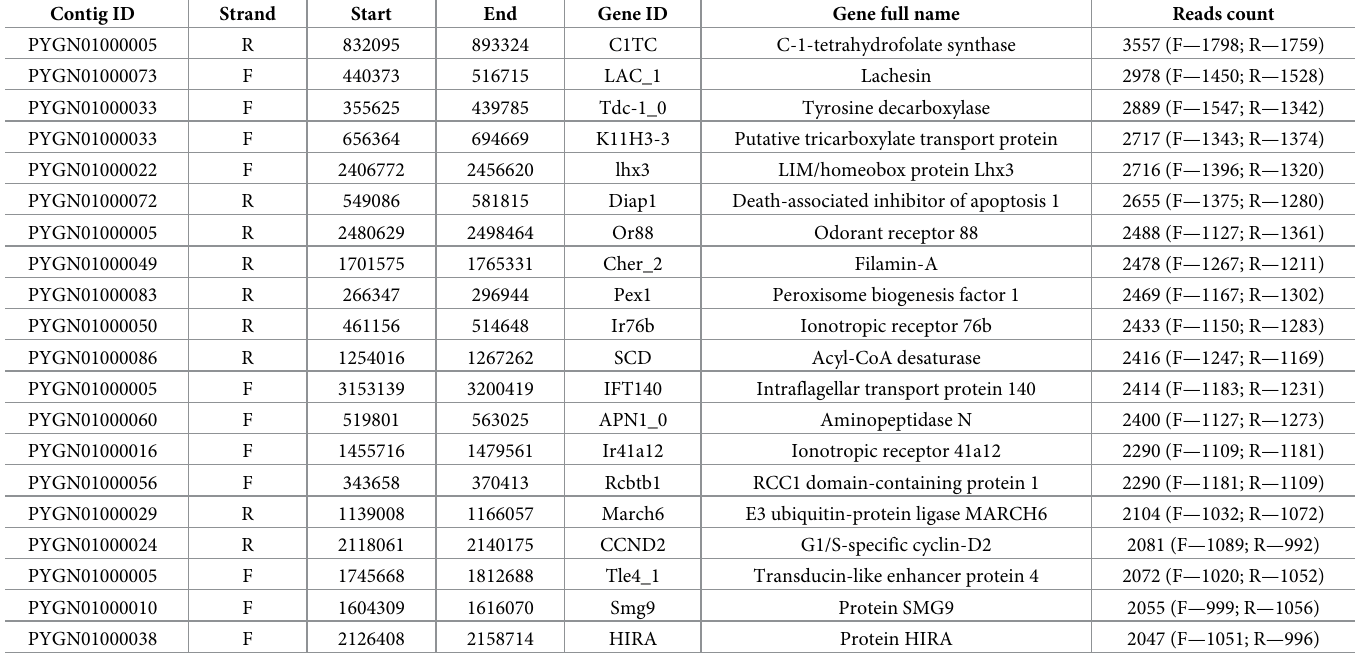
F and R denote forward and reverse complement orientations,